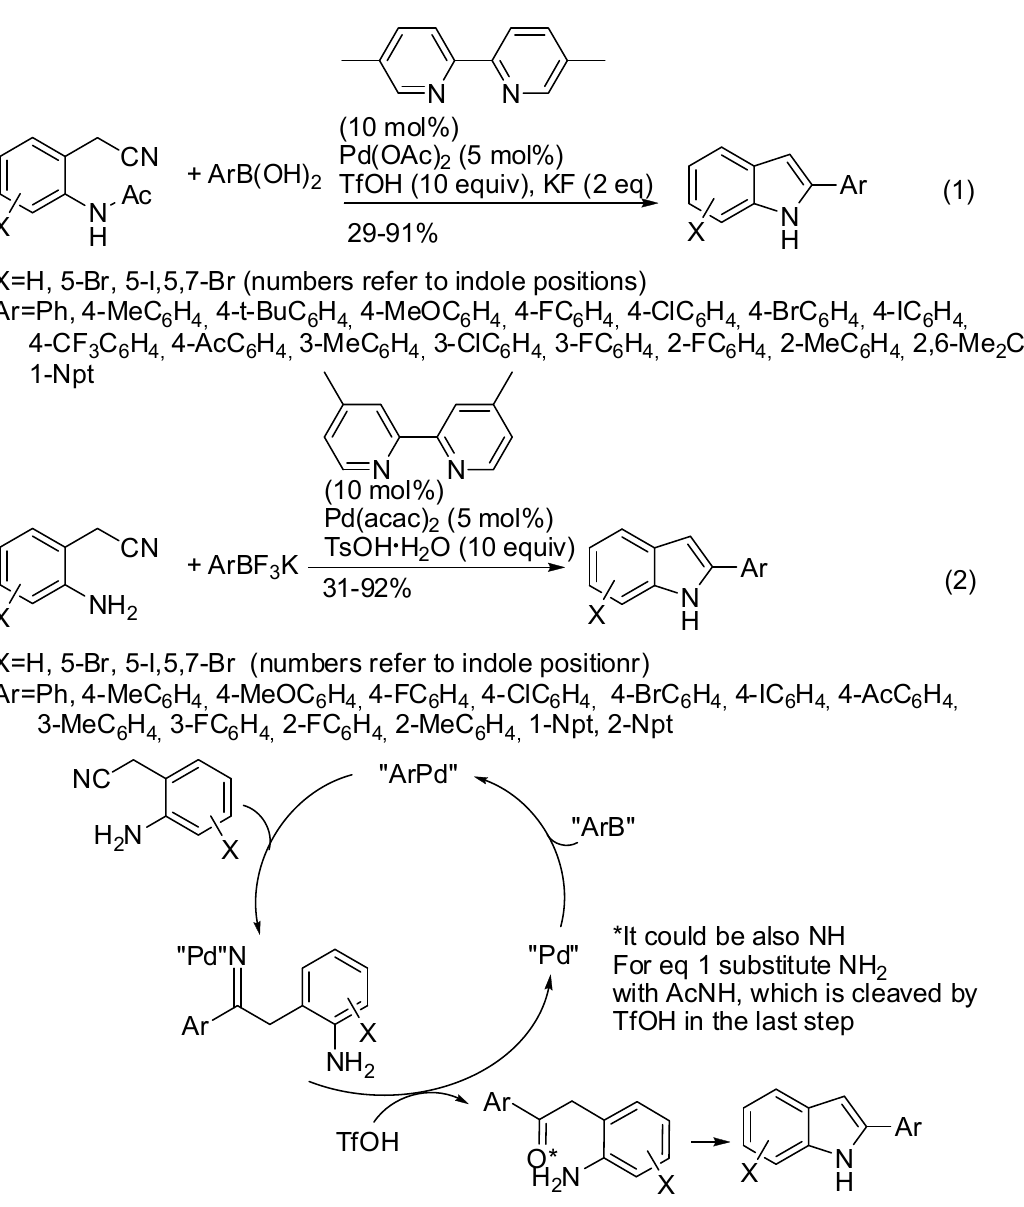
Scheme 32. Palladium-catalyzed tandem addition/cyclization in aqueous